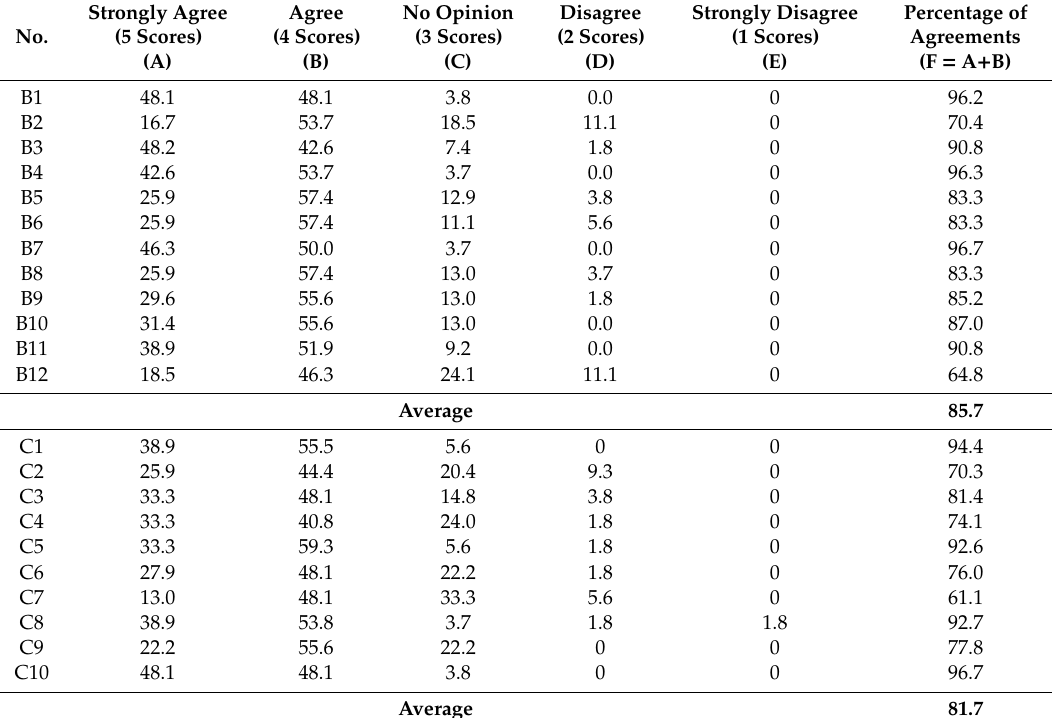
Table 11. Score percentages of the collected data of the two indicators of system usability and writer’s